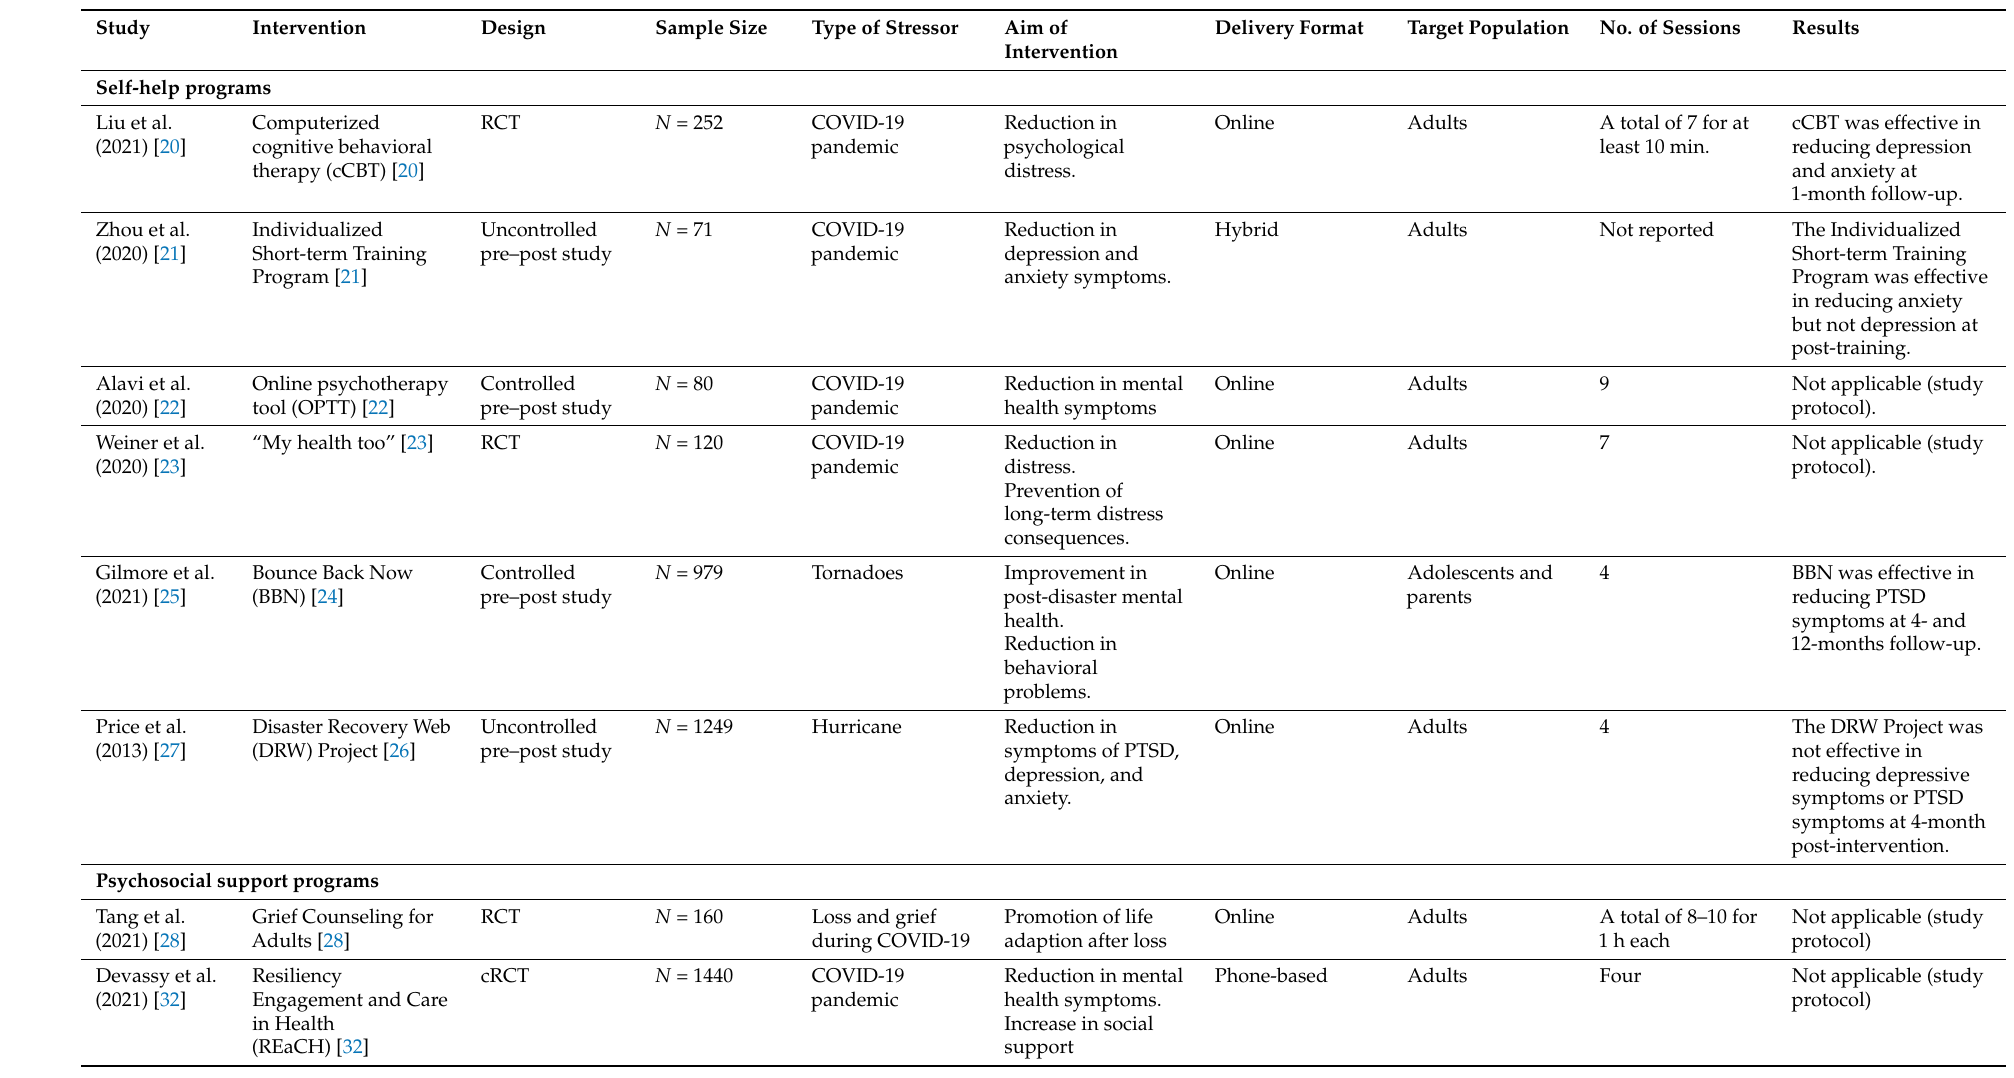
Table A1. Characteristics of brief interventions described in the included articles/protocols ( n =